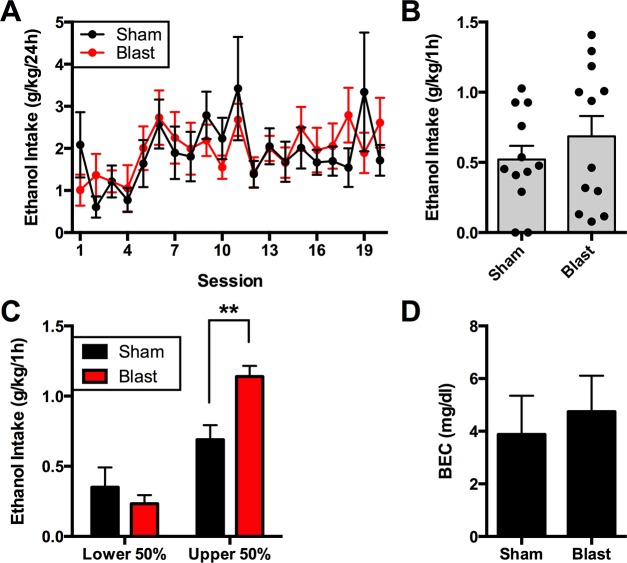
Ethanol intake during intermittent access 20% ethanol two-bottle choice.A) Intake during seven weeks (20 sessions) of two-bottle choice. Tick marks denote the first session of each week. B) Ethanol intake during a 1 hour two bottle choice session (session 21). Blast animals fell into a bimodal distribution, prompting a median split of the data. C) Ethanol intake in lower and upper intake subgroups of sham and blast animals based on median split. **p<0.01. D) Blood ethanol concentration (BEC) in high intake subgroups (n = 6/group). Tail vein blood was collected from rats immediately following a one-hour drinking session and assayed for BEC. Bars represent mean ± SEM, individual data points shown in B.